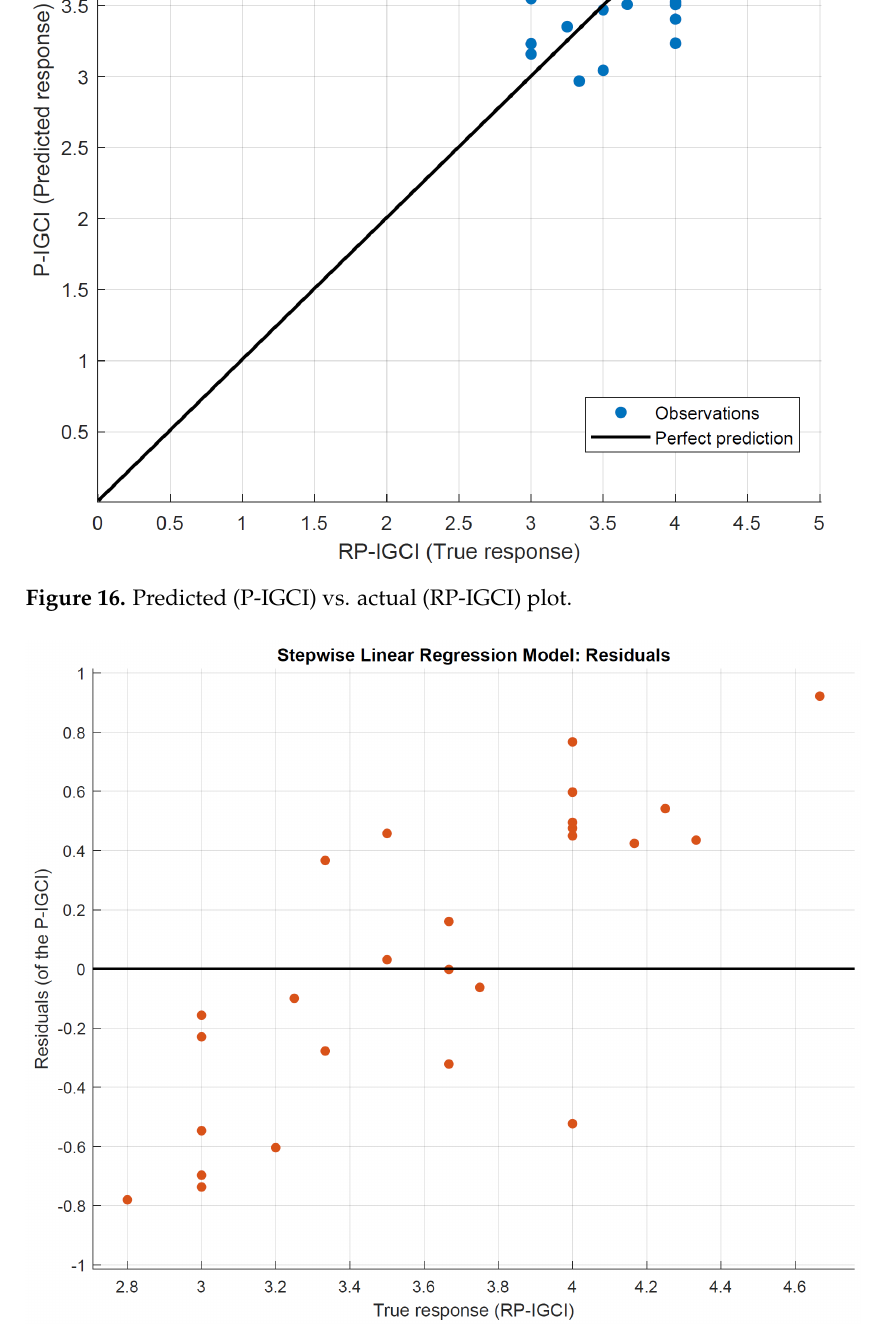
Figure 17. P-IGCI Residuals on true response